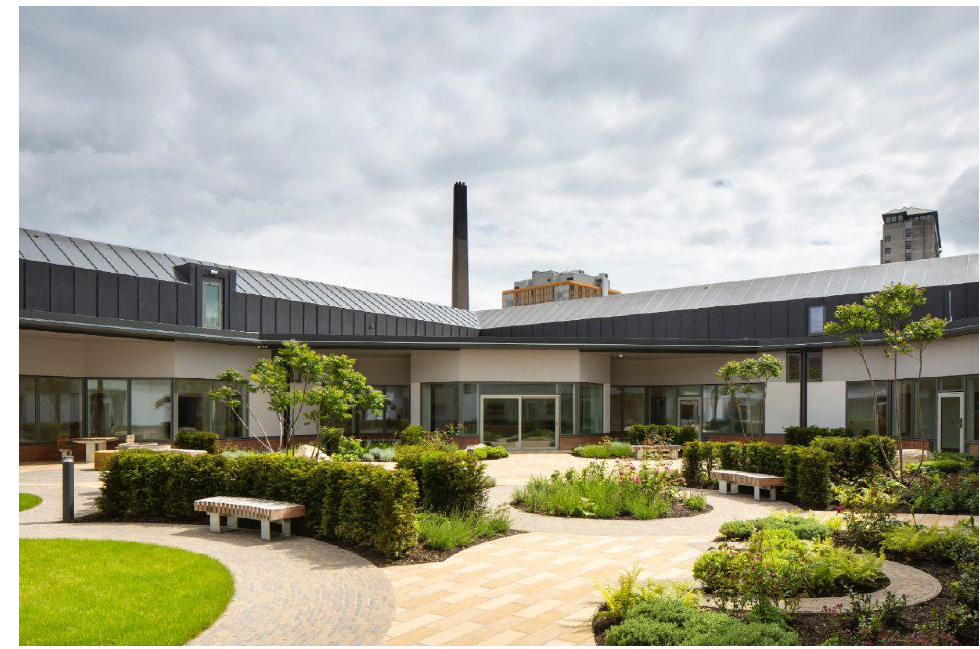
Figure 7. Acute Mental Health Ward in Belfast City Hospital, Northern Ireland.